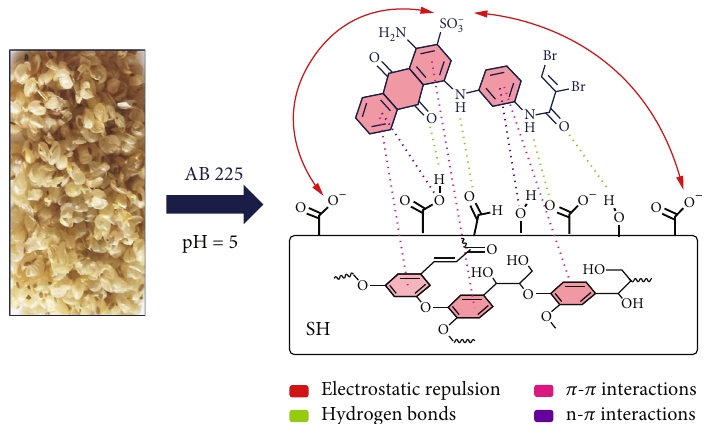
Figure 7: Graphical interpretation of the possible interaction of AB 225 and soybean hulls ’